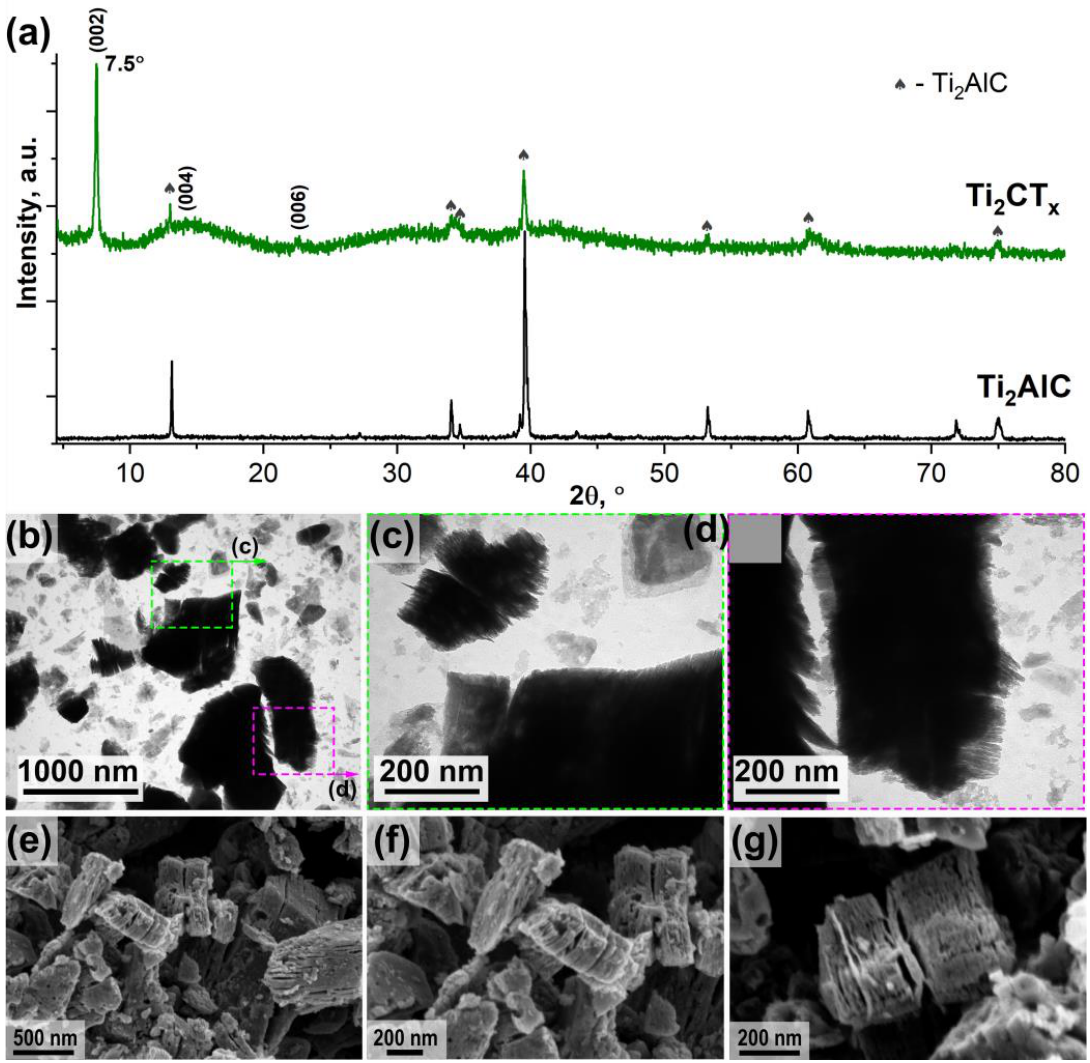
Figure 1. The X-ray powder patterns of the original Ti 2 AlC MAX-phase and the obtained Ti 2 CT x MXene ( a ) and the Ti 2 CT x MXene microstructure particles according to TEM ( b – d ) and SEM ( e – g ).